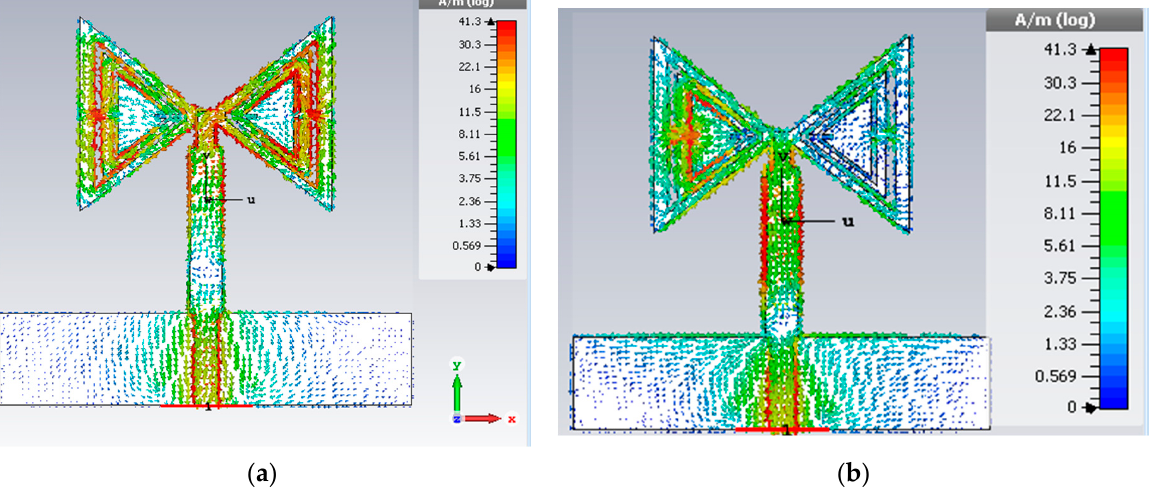
Figure 11. Simulated surface current distribution of the proposed antenna at ( a ) 3.5 GHz and ( b ) 4.9 GHz.